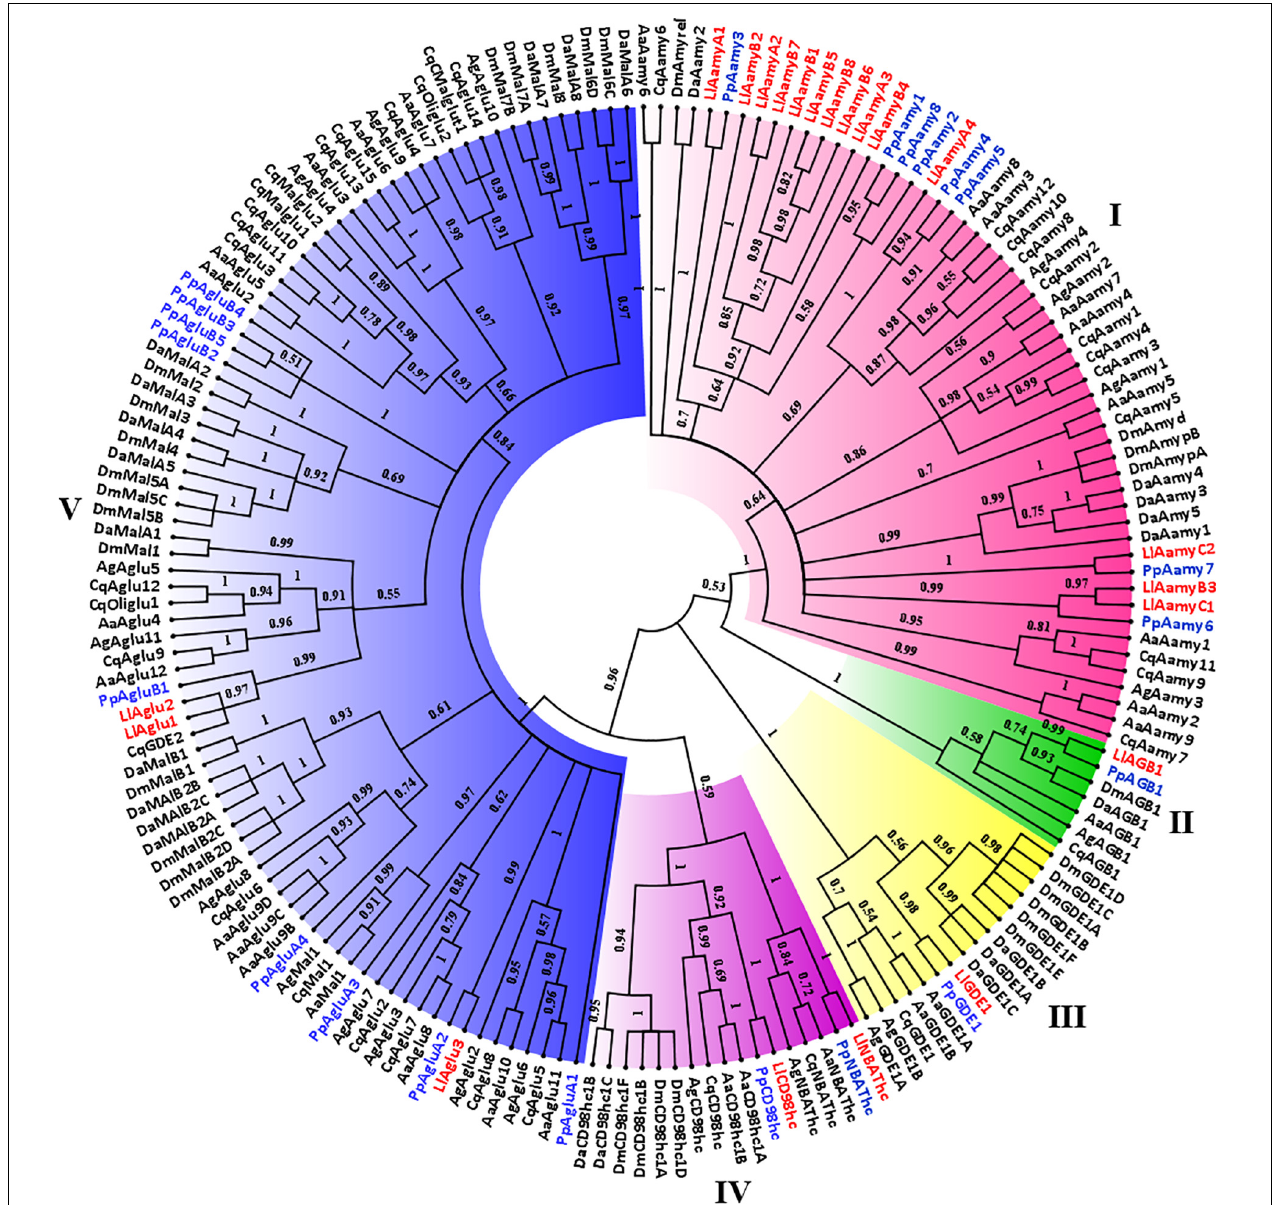
FIGURE 2 | Phylogenetic analysis of L. longipalpis GH13 proteins. Radial cladogram represents the alignment of GH13 protein sequences, α -amylases (Aamy, red), α -glucosidases (Aglu or Mal, blue), amino acid transport proteins (CD98hc and NBAThc, purple), 1,4- α -branching enzymes (AGB, green), glycogen debranching enzymes (GDE, yellow), of L. longipalpis and other dipterans species. L. longipalpis sequences are highlighted in red and P. papatasi in blue. L. longipalpis (Ll), P. papatasi (Pp), A. aegypti (Aa), A. gambiae (Ag), C. quinquefasciatus (Cq), D. melanogaster (Dm) and D. ananassae (Da). The tree represents the bootstrap consensus of 500 replicates, visualized with FigTree v1.4.3. Bootstrap values for the nodes are represented. The identifiers and corresponding genes are specified in Additional file 1.